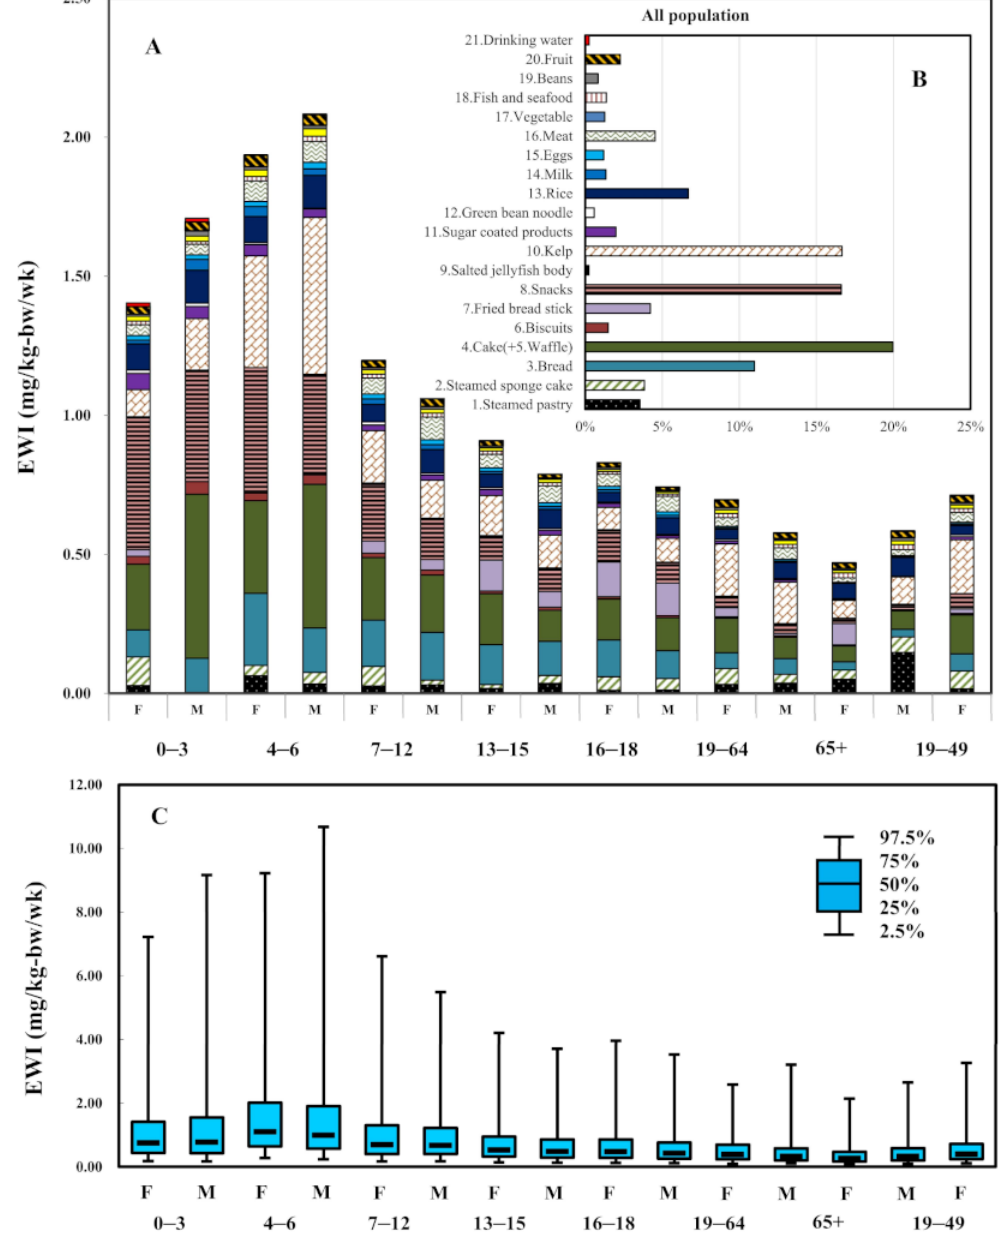
Figure 4. ( A ) Estimated weekly intake (EWI, mg/kg-bw/wk) of 21 food items for all age-sex groups. ( B ) Contribution percentage (%) for the whole population, excluding the age groups from 19–45 years (children bearing age), among 21 food items ( C ) Box-whisker plot with 95% confidence interval of EWI